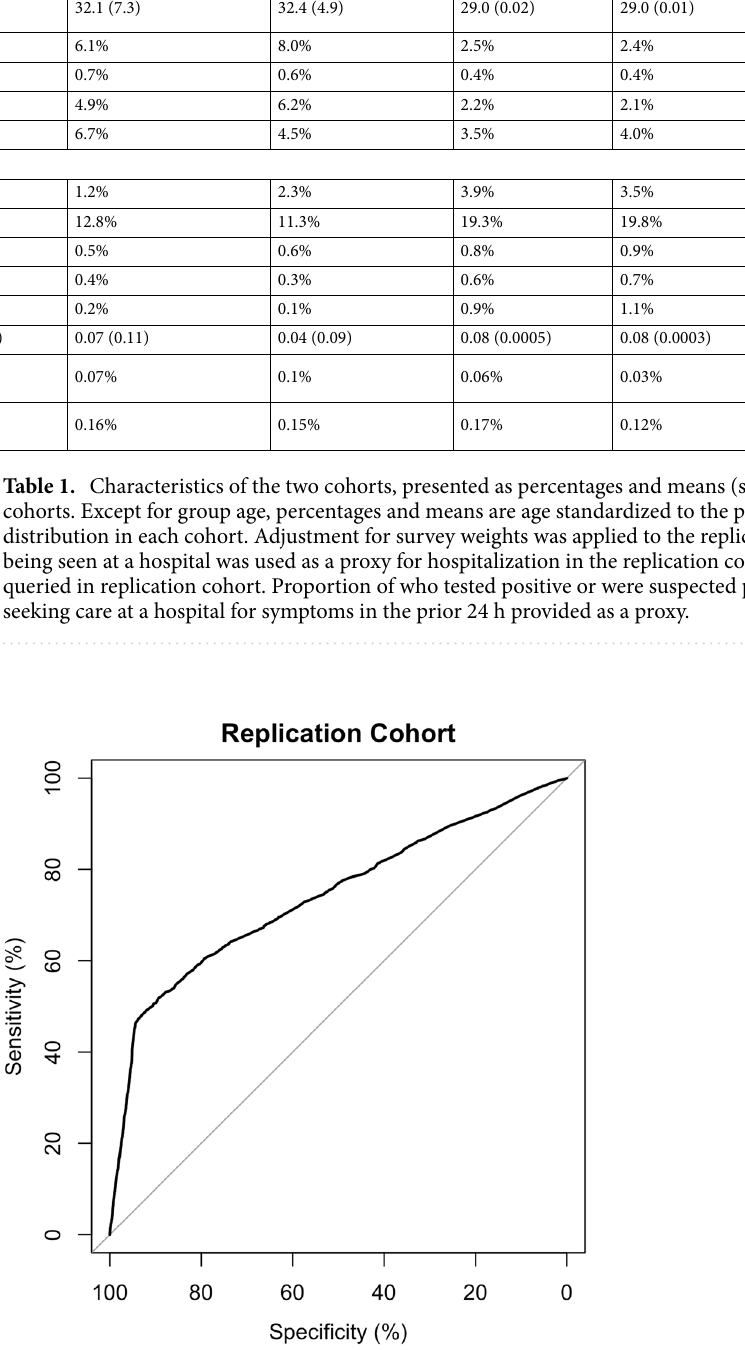
Figure 1. Receiver operating characteristics curve showing validation of the imputation of SARS-CoV-2 test status using the mapped symptom score probability in the replication cohort. Area under the curve is